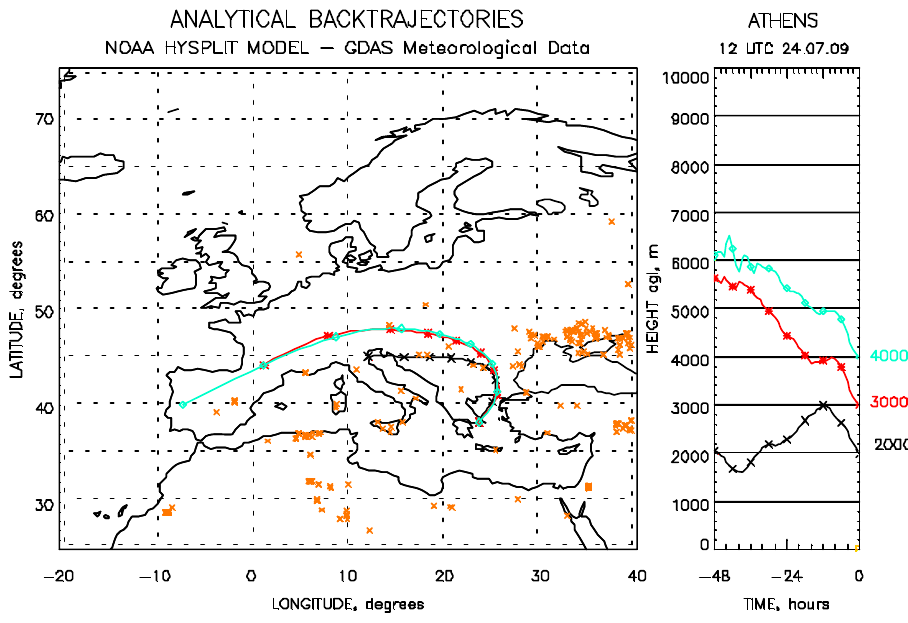
Fig. 6. Back-trajectories of air masses arriving over Athens on 24 July 2009 (12:00UT) at various heights (2000m, 3000m, 4000m). The orange points indicate the active hot spots from biomass burning sites. Time step is